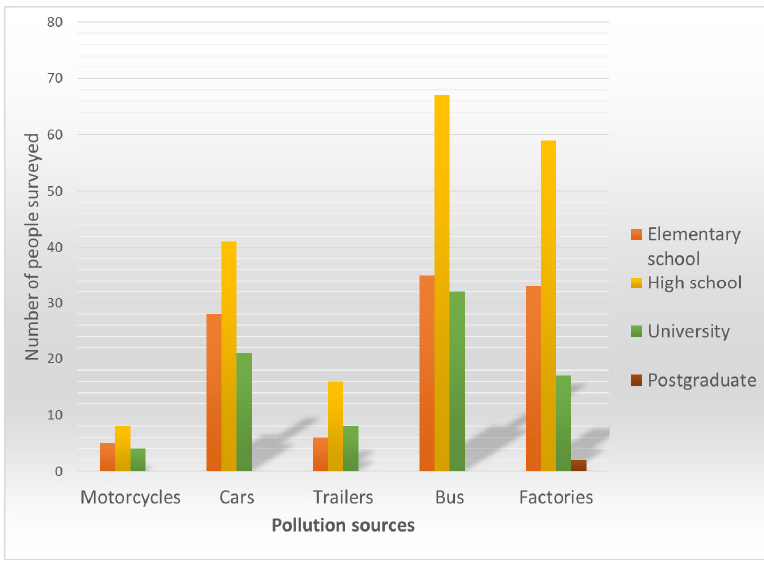
Figure 9. What do you think pollutes more (by education)?